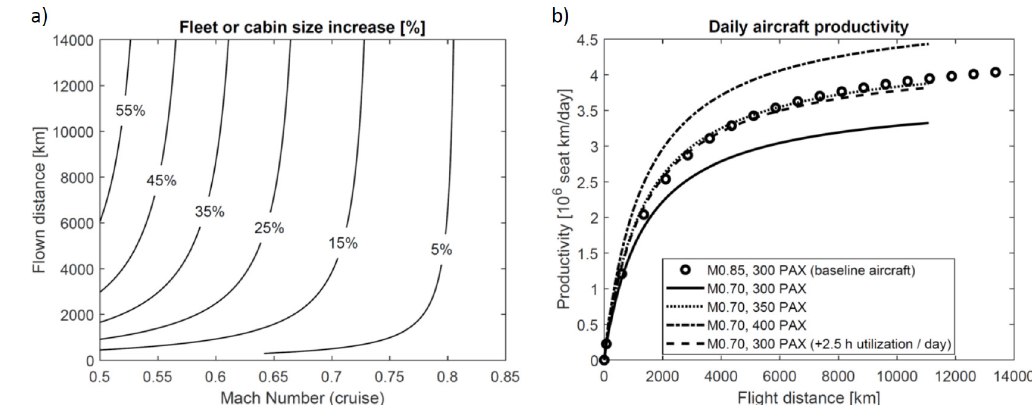
Figure 1. Aircraft productivy depending on flight speed, flight distance, and cabin size. a) The relative required increase in cabin size or fleet is shown as a function of flight distance and cruise Mach number. At short distances, productivity is predominantly limited by ground time, rather than flight speed. b) Daily aircraft productivity as measured in seat kilometers is shown as a function of flight distance, considering variations in flight speed, ground time, and